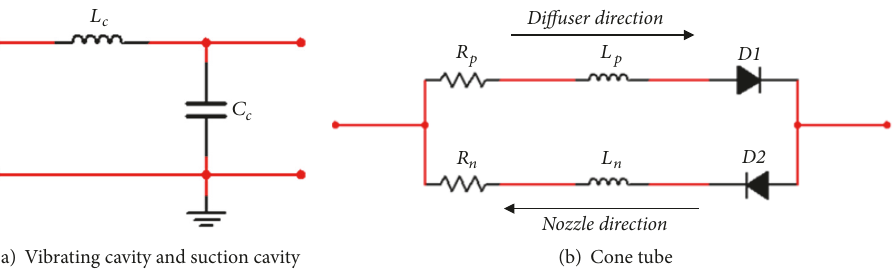
Figure 14: Equivalent electric network model of